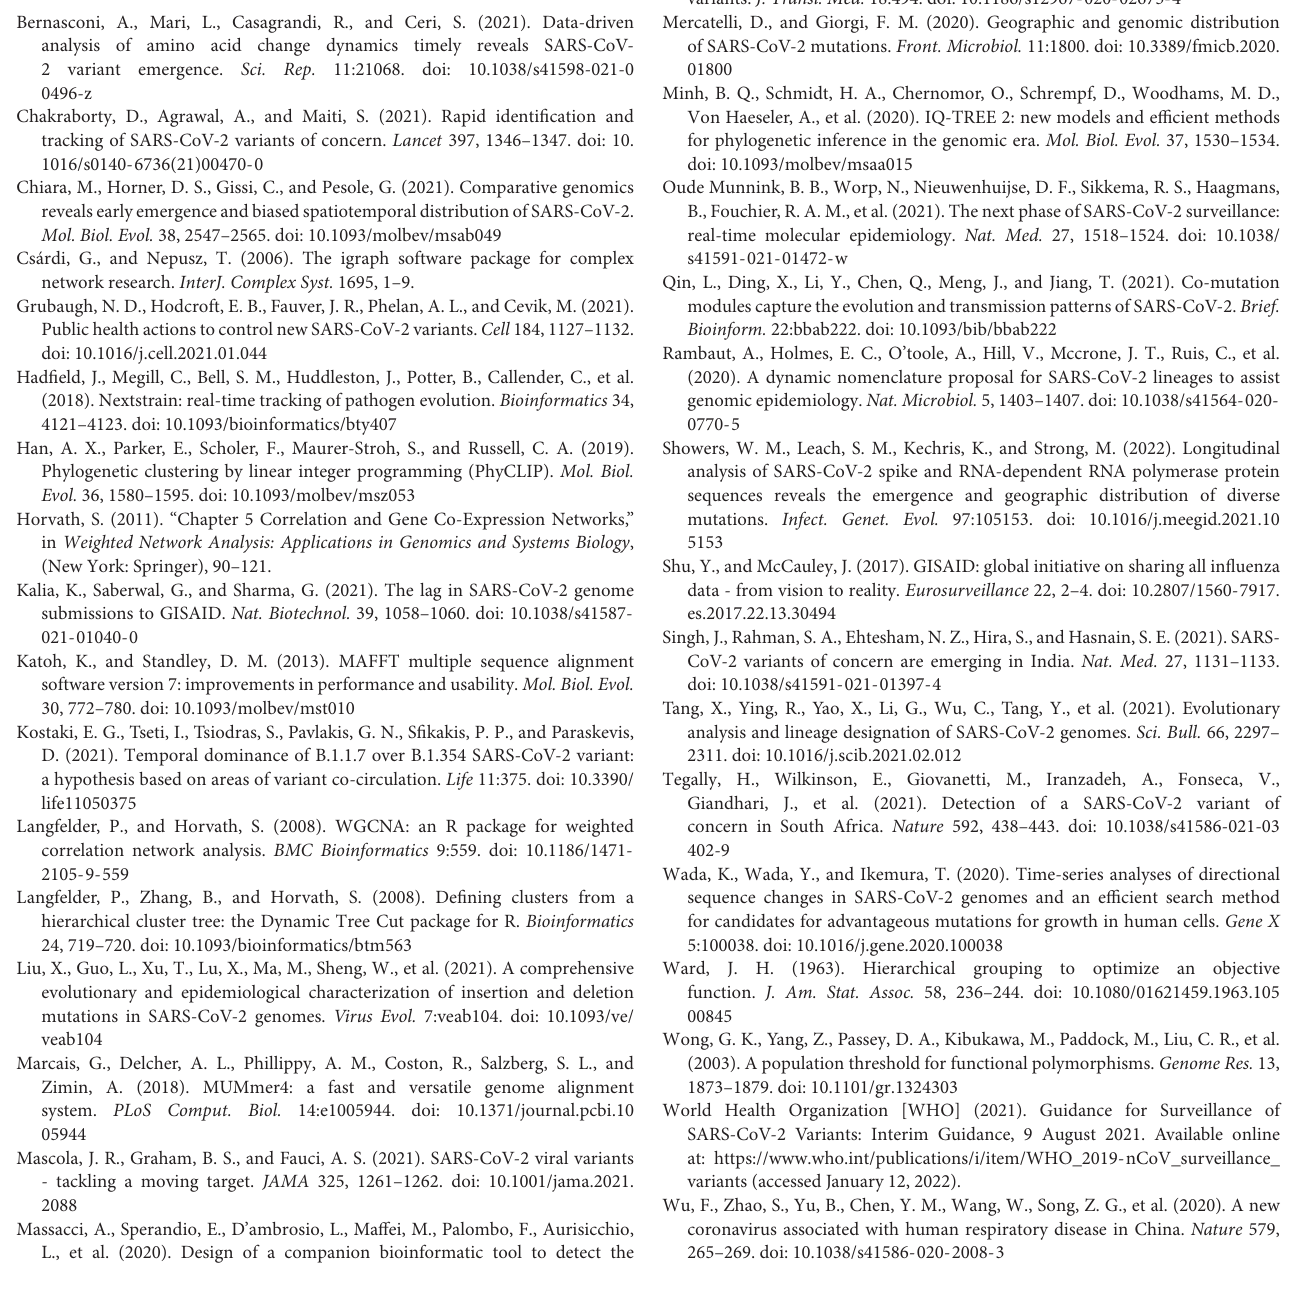
Supplementary Figure 3 | Frequency trajectories of mutations by SARS-CoV-2 genome regions. UTR, Untranslated region; NSP, non-structural protein; S, Spike protein; ORF, Open reading frame; M, Membrane protein; N, Nucleocapsid protein; E, Envelope protein. Supplementary Figure 4 | Network graphs with different topological overlap cutoffs for identification of worldwide pandemic variants. Supplementary Figure 5 | The global SARS-CoV-2 phylogenic skeleton. (A) The SARS-CoV-2 phylogenic skeleton generated by the Nextstrain pipeline based on a random sample of the global phylogenic tree from the GISAID database, with the